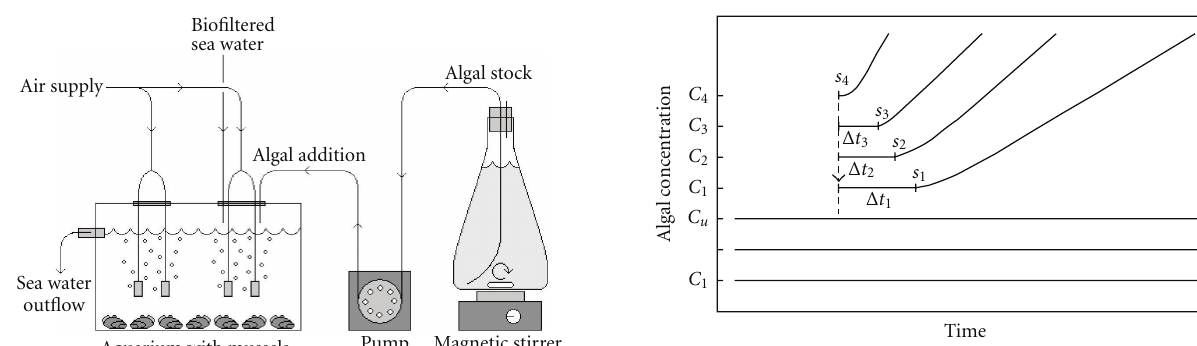
Figure 1: Experimental setup for performing steady-state experi- ments with mussels at defined algal concentration.